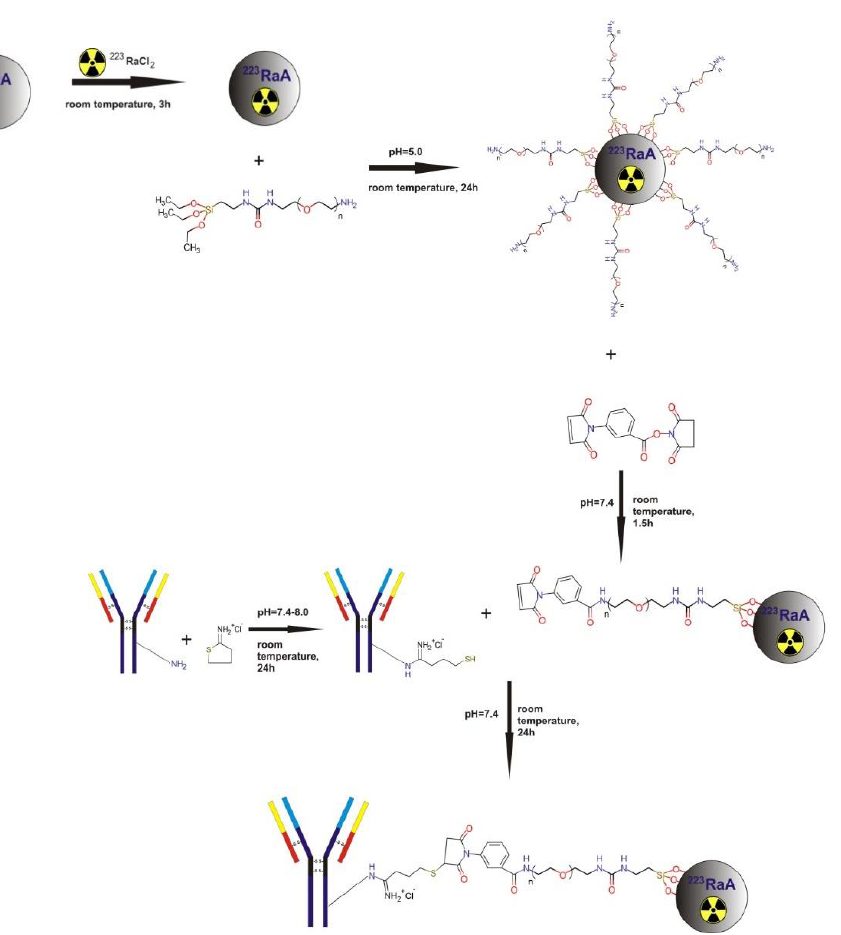
Figure 1. Steps of the 223 RaA-silane-PEG-D2B radiobioconjugate synthesis.